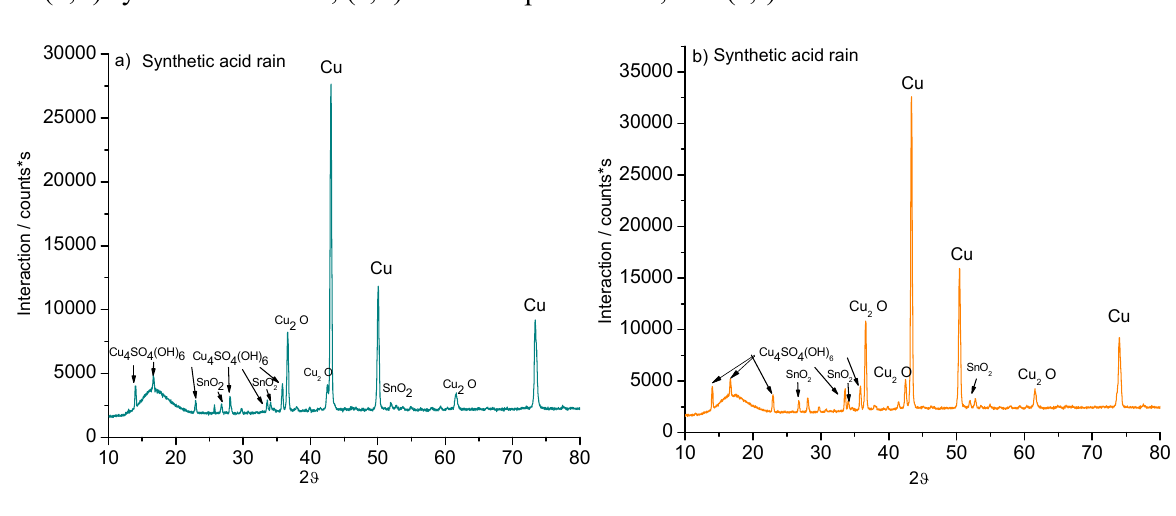
Figure 5. XRD patterns of ( a , c , e ) 3% Sn bronze and ( b , d , f ) 7% Sn bronze in ( a , b ) synthetic acid rain; ( c , d ) 0.1 M sulphuric acid; and ( e , f ) 0.1 M nitric